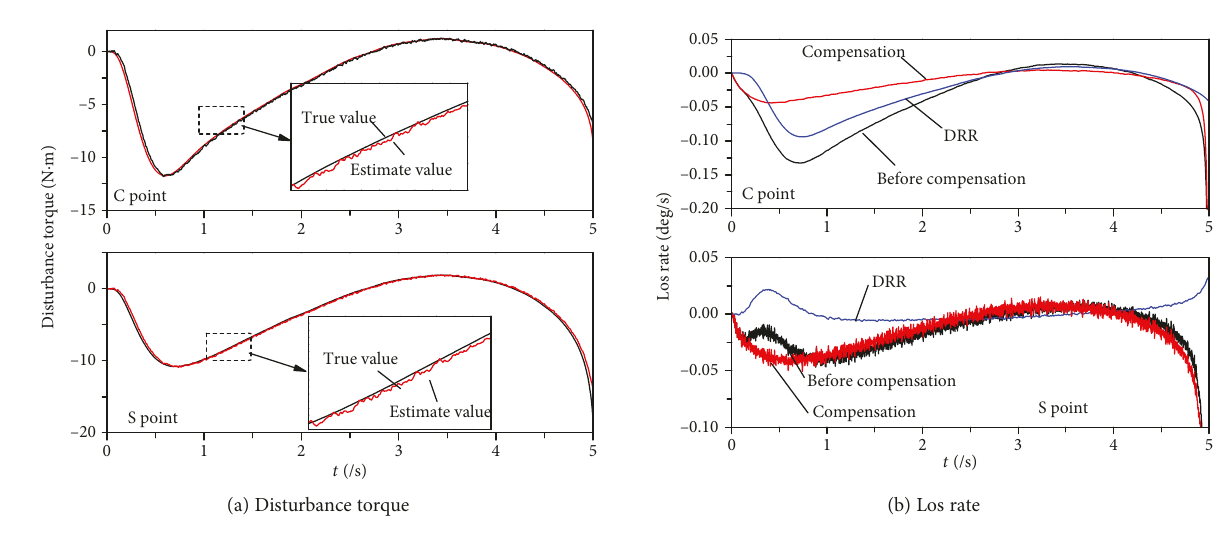
Figure 18: Spring torque.